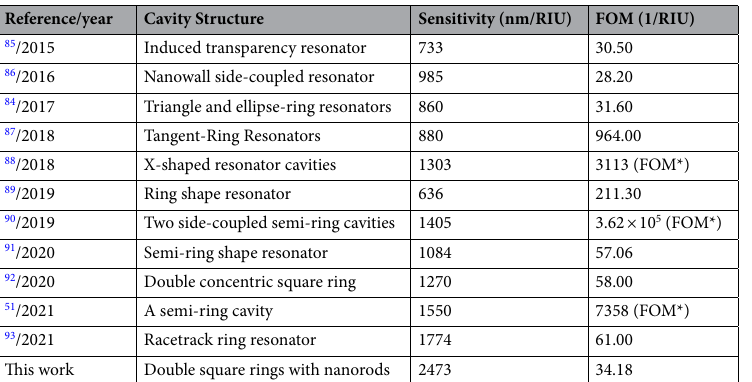
Table 3. Comparison of the best sensitivity and FOM between this work and some selected published articles. P. S. FOM* = max(|dT(λ)/d n (λ)/T(λ) |), where T (λ) is the transmittance, and dT(λ)∕d n (λ) is the transmittance change at a fixed wavelength induced by a refractive index